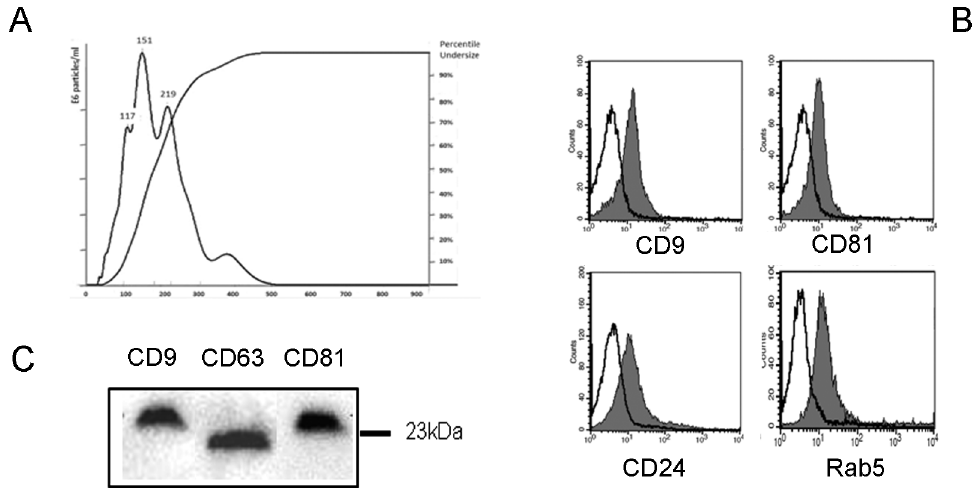
Figure 1. Characterization of normal urinary EVs. Panel A. NanoSight analysis of samples prepared from the urine of normal subjects showing their size distribution profile. A peak at 151 nm was observed. Panel B and C . Representative images of the expression of exosome markers by urinary EVs by cytofluorimetric (B) and Western Blot analysis (C). Cytofluorimetric histograms show marker detection (grey area) and isotypic control (dark line). Five different preparations were tested with similar results.